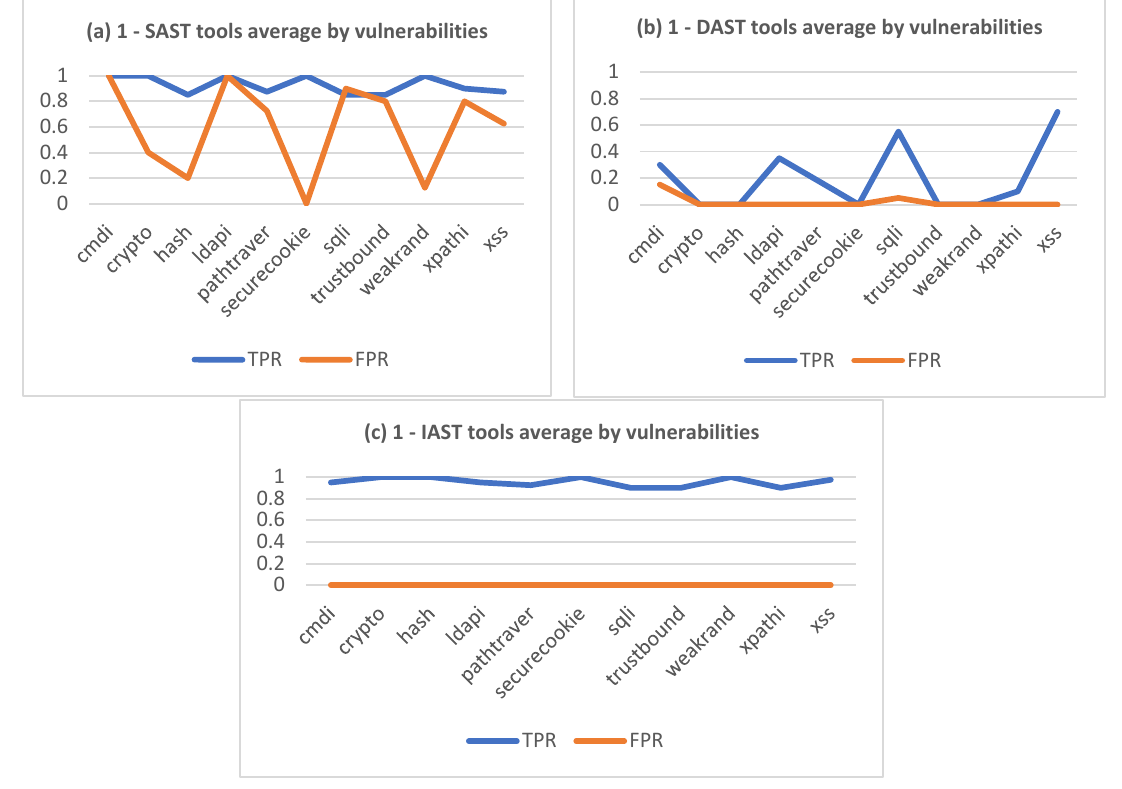
Figure 2. E ff ectiveness of each type of AST tool considering each type of vulnerability Figure 2. Effectiveness of each type of AST tool considering each type of vulnerability without without combination.